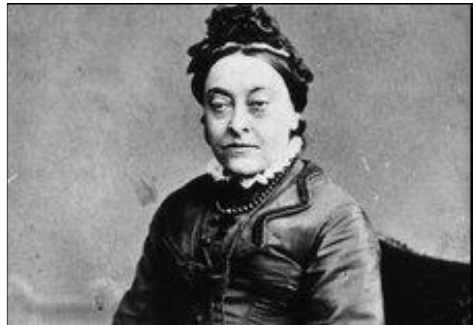
Figure 1. Christina Rossetti, 1887, photograph by Elliott and Fry (1992).